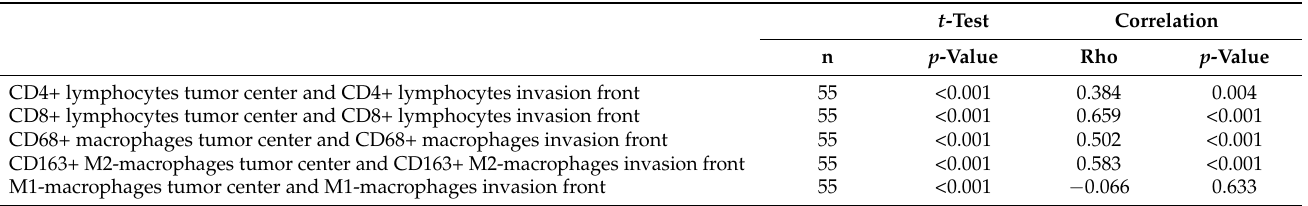
Table 3. Paired t -test and Spearman’s correlation of immune cell counts for tumor center vs. inva- sion front.